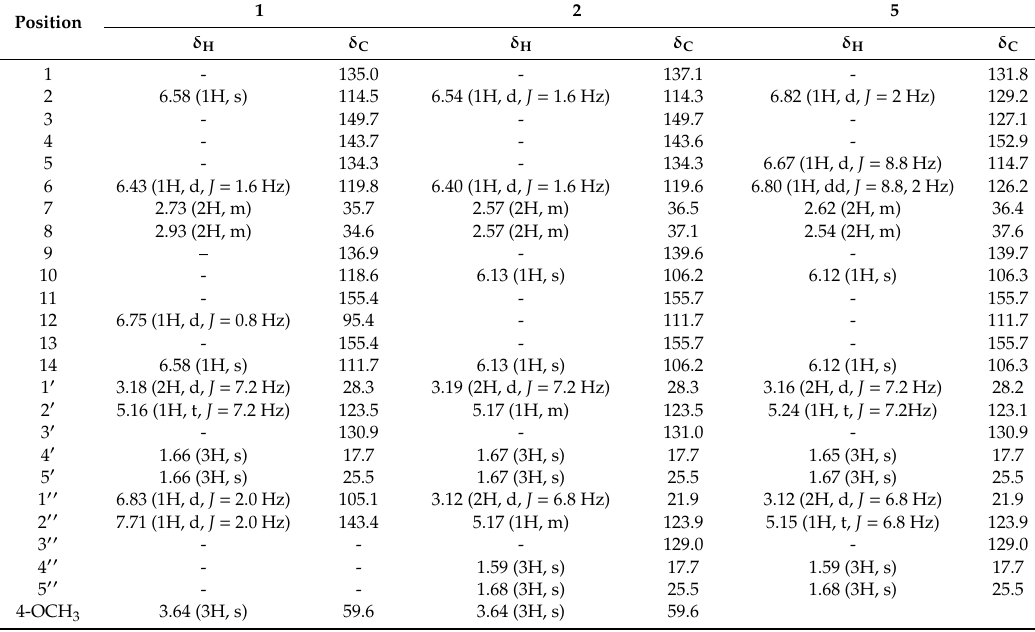
Table 1. 1 H- and 13 C-NMR spectroscopic data of compounds 1 , 2 and 5 (400 MHz for 1 H-NMR